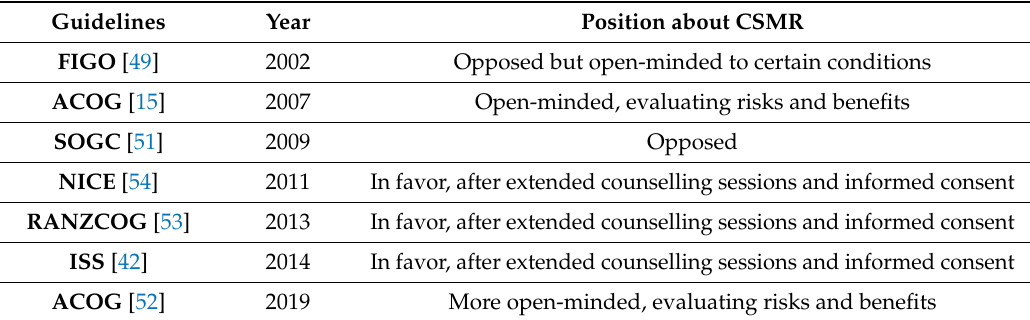
Table 3. International guideline